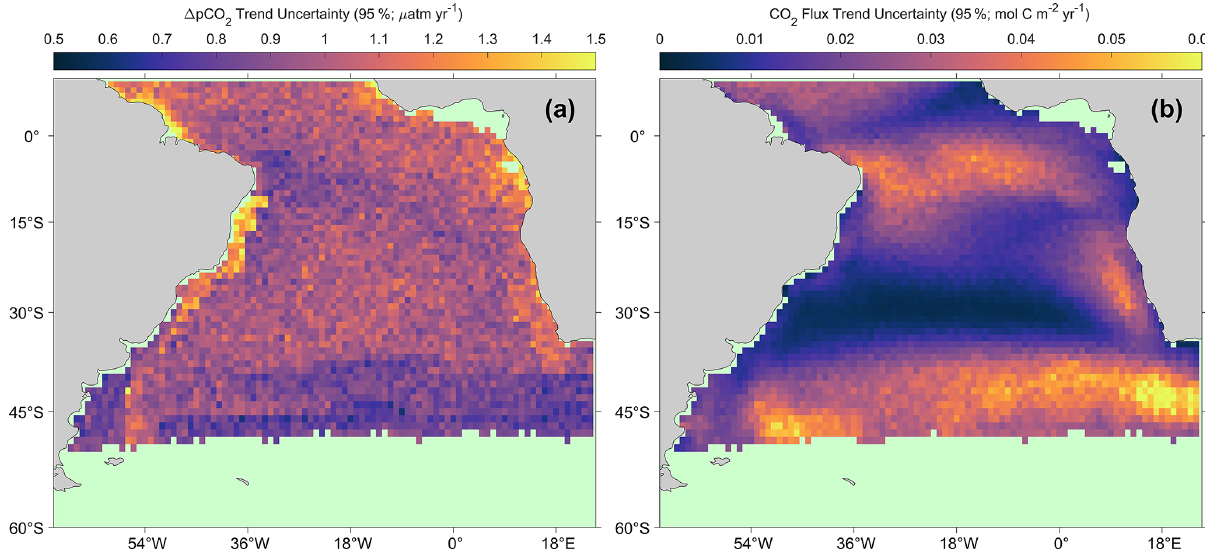
Figure B2. (a) Uncertainty in the (cid:49)p CO 2 trends presented in Fig. 5a. (b) Uncertainty in the air–sea CO 2 flux trends presented in Fig. 5b.